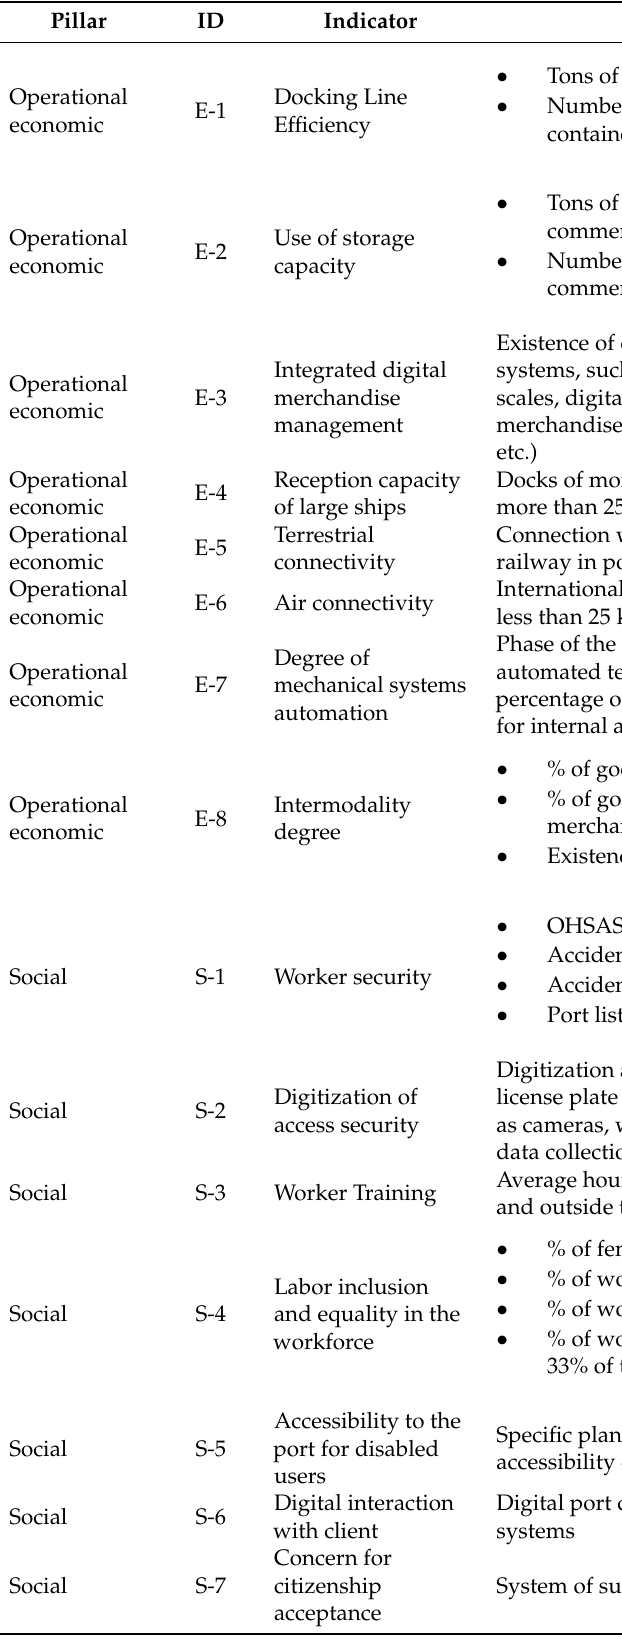
Table 1. Selected indicator and measurement